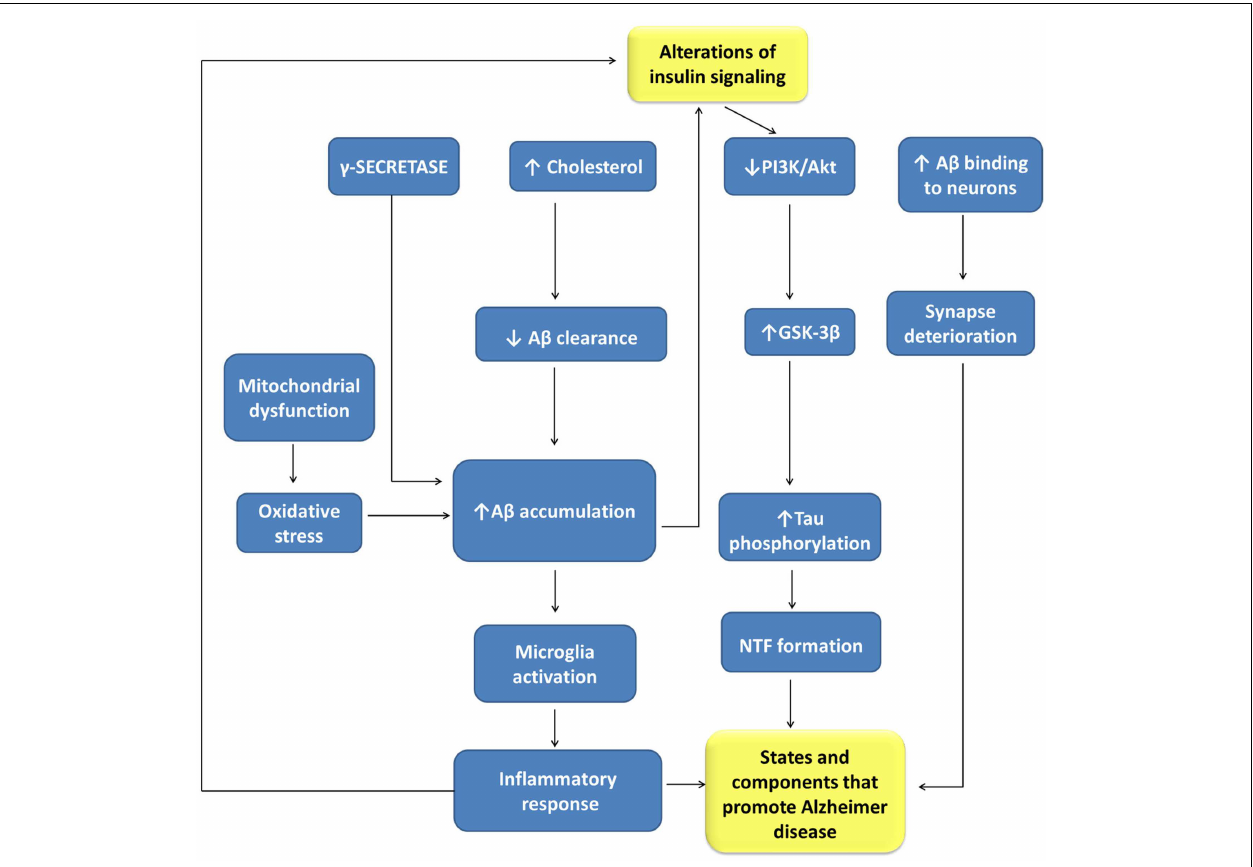
FIGURE 3 | Relationships between alterations of insulin signaling andAlzheimer disease pathogenesis . A β , beta amyloid-peptide; GLUT-3, glucose transporter isoform-3; GSK-3 β , glycogen synthase kinase 3- β ; NFT, neurofibrillary tangles; PI3K, phosphatidyl inositol